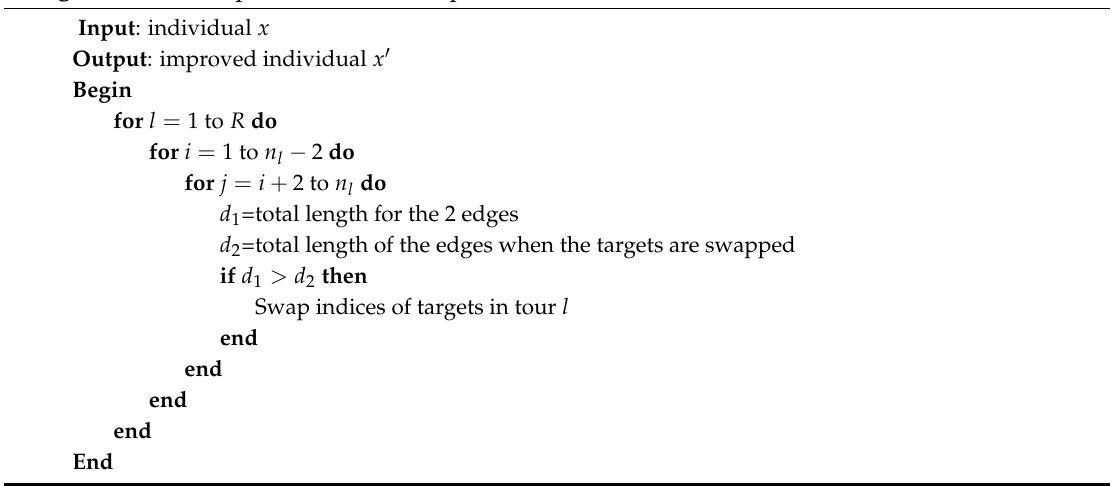
Algorithm 8: The pseudo-code of 2_opt